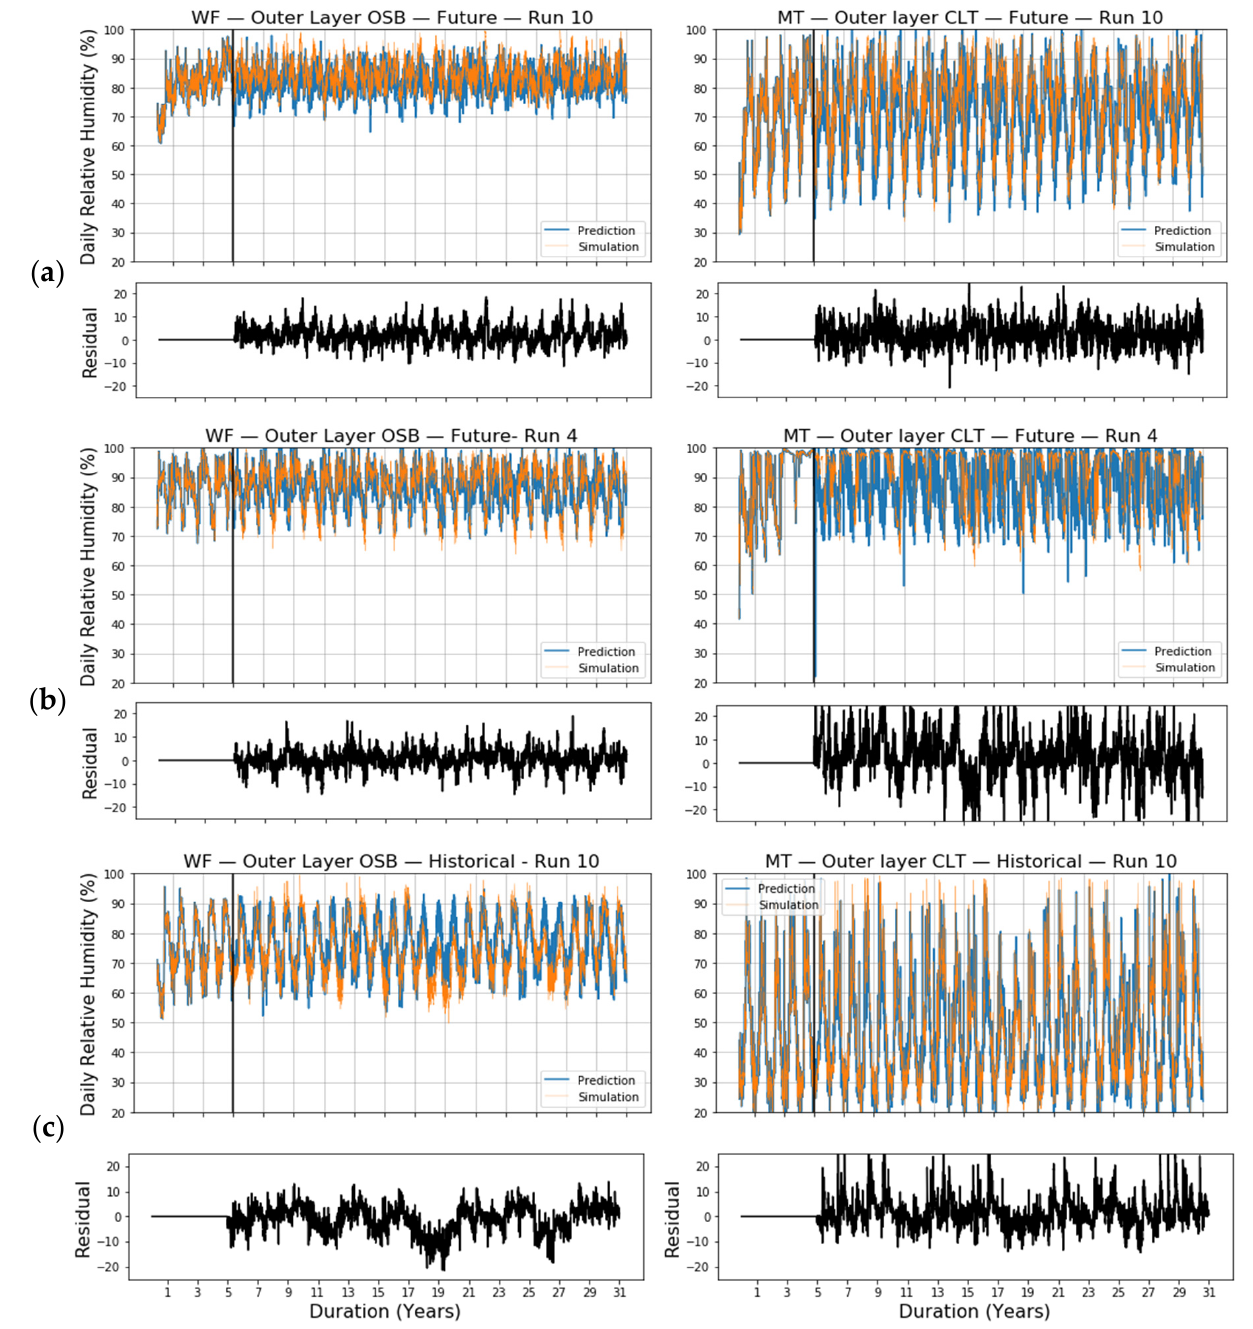
Figure 8. Comparisons of SVR predictions and hygrothermal simulation results for the relative humidity of the outer layer of OSB in wood frame (WF) and outer layer of CLT in mass timber (MT) walls in the cities of ( a ) Ottawa, ( b ) Vancouver, and ( c ) Calgary.